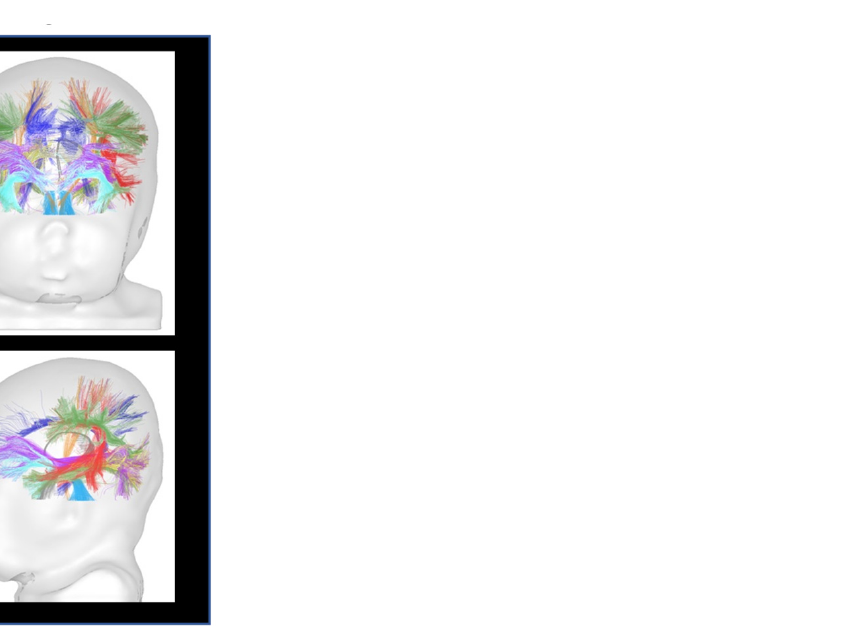
Figure 2. Tractography of WM bundles in a 1-month-old infant. The trajectory of the main WM bundles (projections, callosal tracts, limbic, and associative bundles) can be generated. Adapted from ref. [36] .